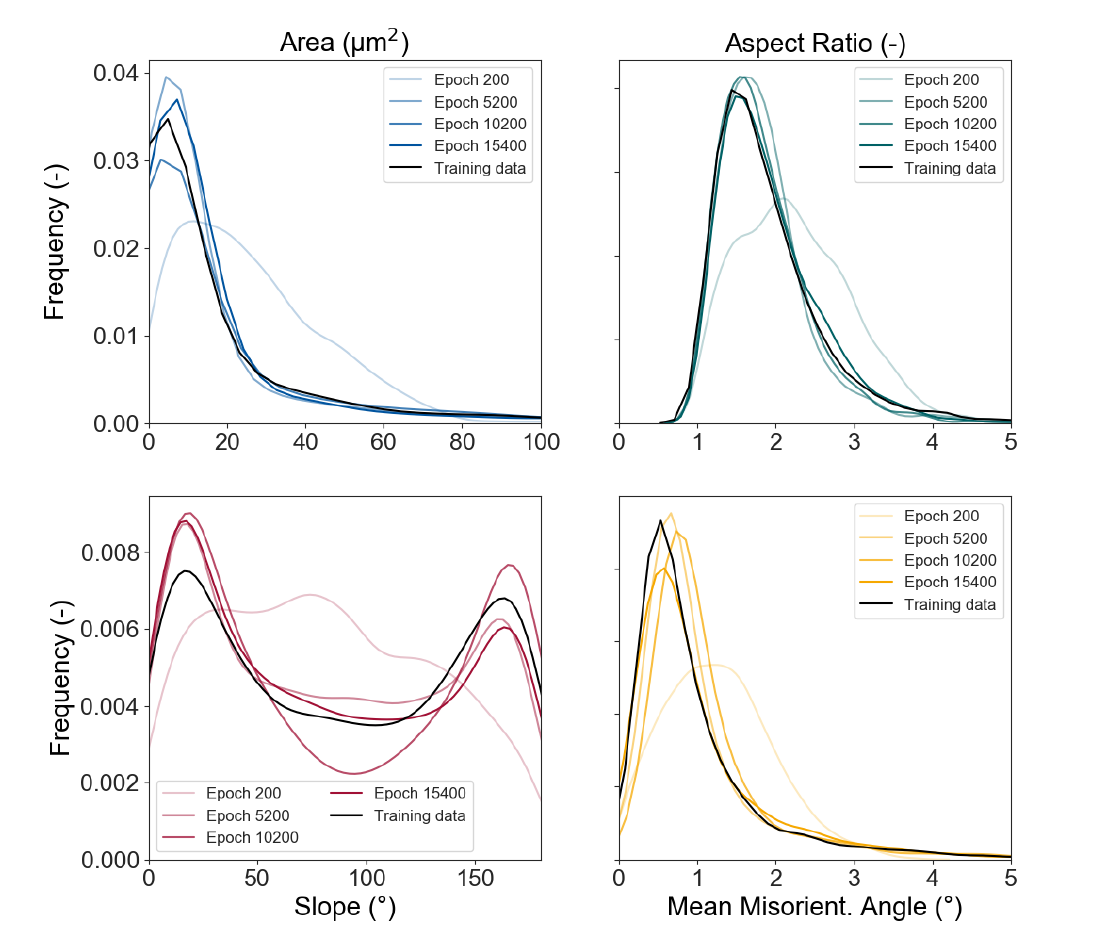
Figure 6. Development of the output of the neural networks (NN) over multiple epochs, compared to the input data. Epoch 15,400 is the best fit for the applied input